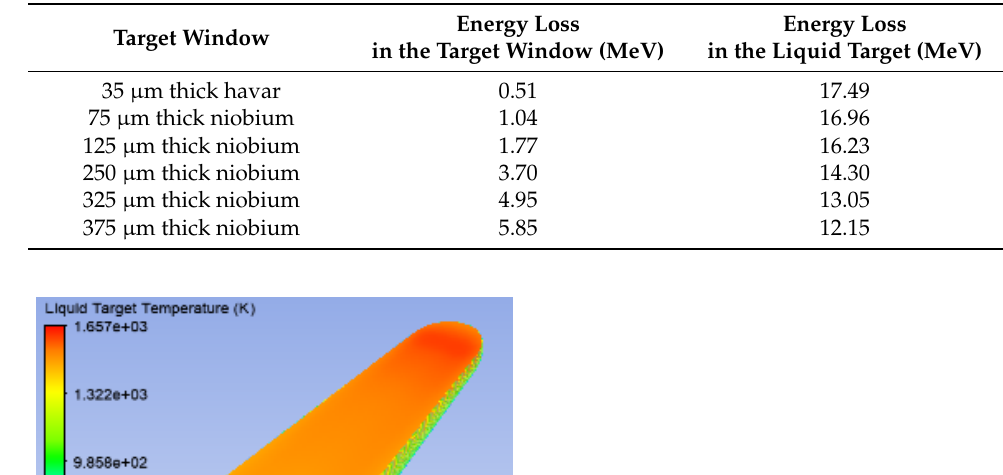
Table 3. Beam energy loss in the target window and the liquid target for the different target windows used.